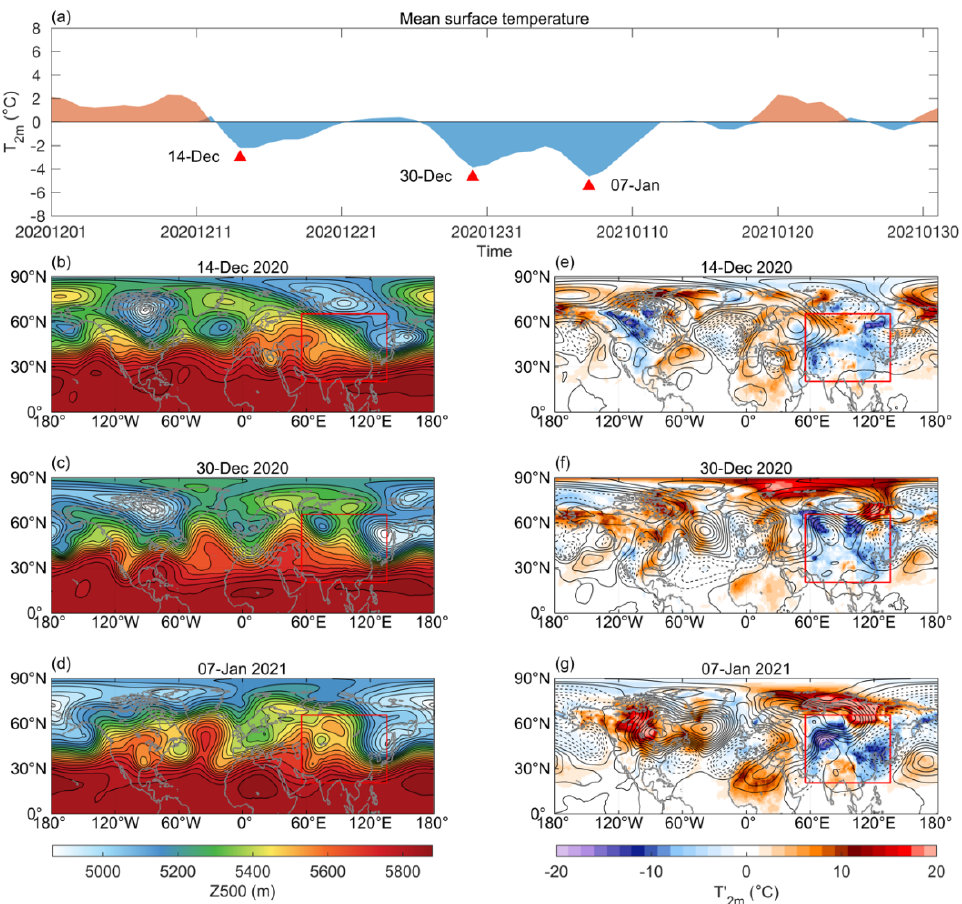
Figure 1. Cold surge in 2020/2021 winter: ( a ) time series of spatial-mean T 2m of East Asia from 1 December 2020 to 31 January 2021. ( b – d ) Z500 fields on the three days marked in ( a ); ( e – g ) Z500 (contours) and T 2m (shaded) anomalies on the three days marked in ( a ). The contour interval for ( b – g ) is 40 m. The area of East Asia is defined by a red rectangle in ( b – g ).